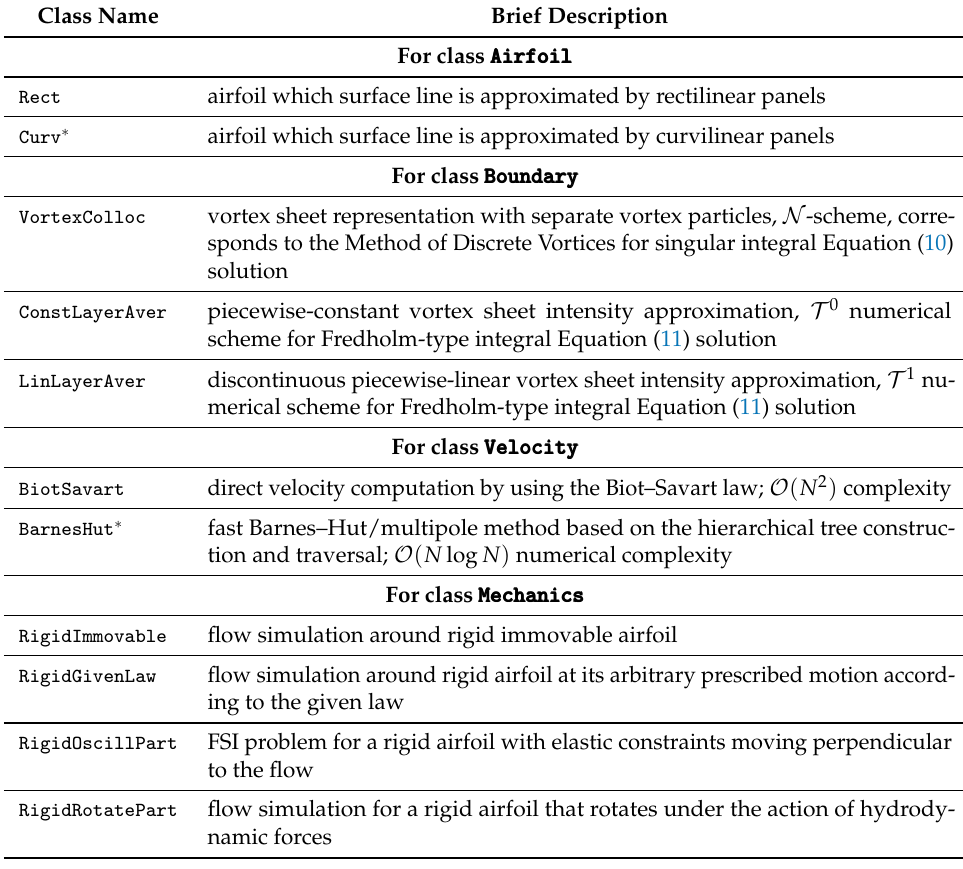
Table 3. Abstract classes